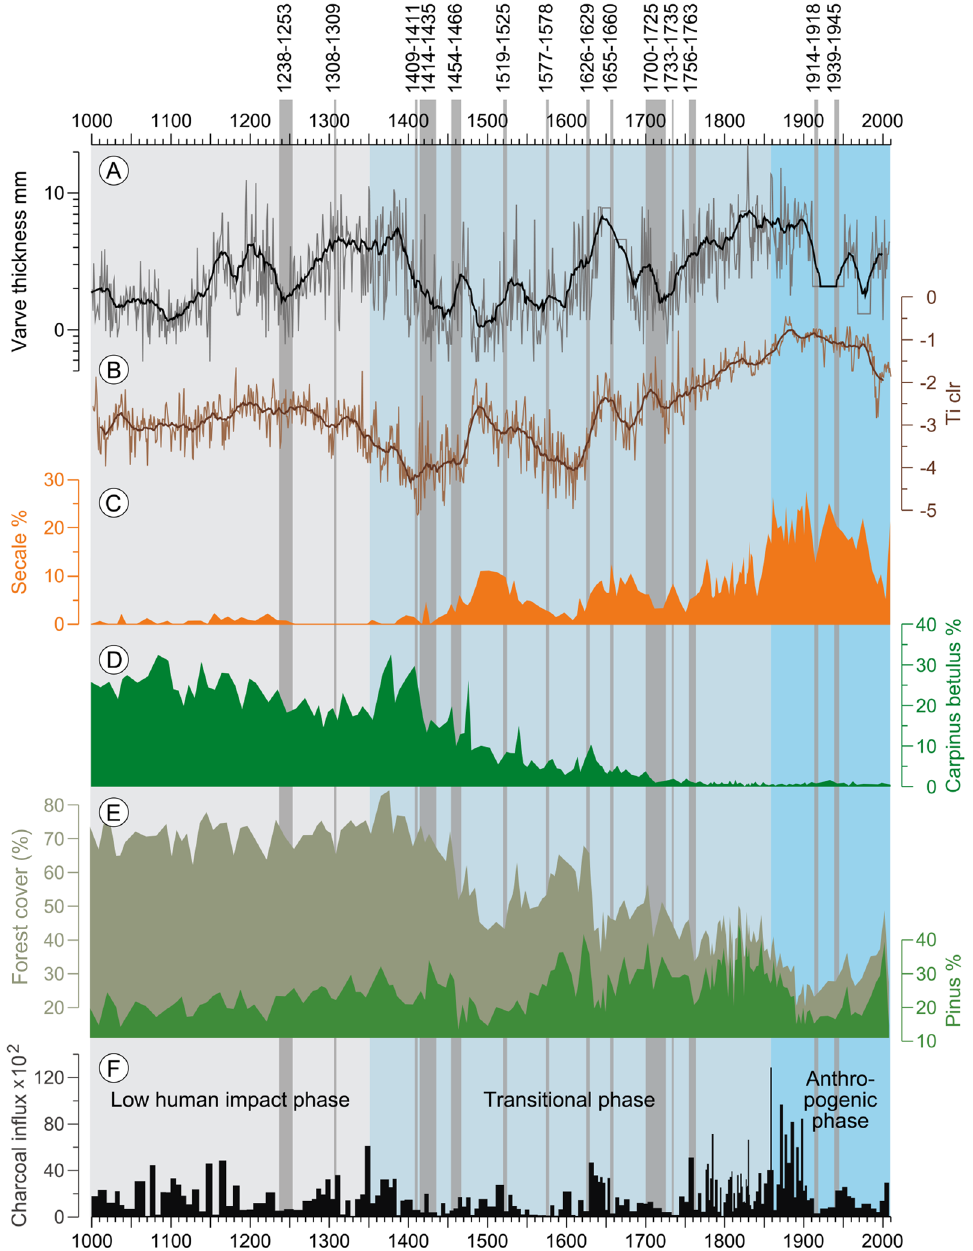
Figure 2. Sediment proxy data for the last 1000 years obtained from Lake Czechowskie cores. From top to bottom: ( A ) Varve thickness (21 running mean (bold line) and annual data; ( B ) Titanium (Ti) counts (clr) from XRF scanning at 50 mm resolution and 21 running mean (bold line) as proxy for detrital catchment material. ( C ) Secale % (indicator for agricultural land area), ( D ) Carpinus % (hardwood species used for buildings), ( E ) Forest cover % (proxy for land openness) and Pinus % (typical regional pioneer tree species) all pollen data are presented REVEALS transformation with the REVEALSinR function from the R package ‘disqover’ (Theuerkauf, et al. 57 see methods). ( F ) Charcoal influx as proxy for fires. The grey bars indicate periods of wars in the